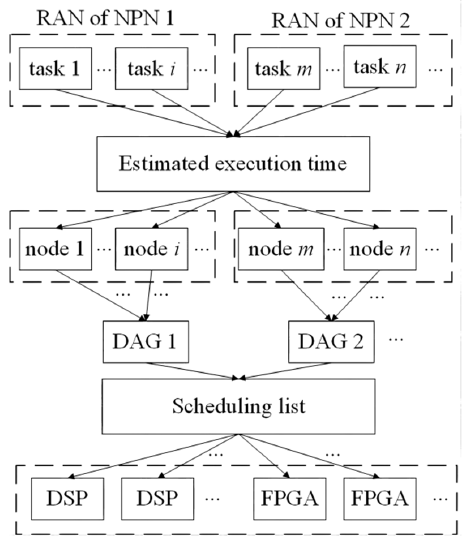
Figure 4. Virtualization of RAN based on DAG model.